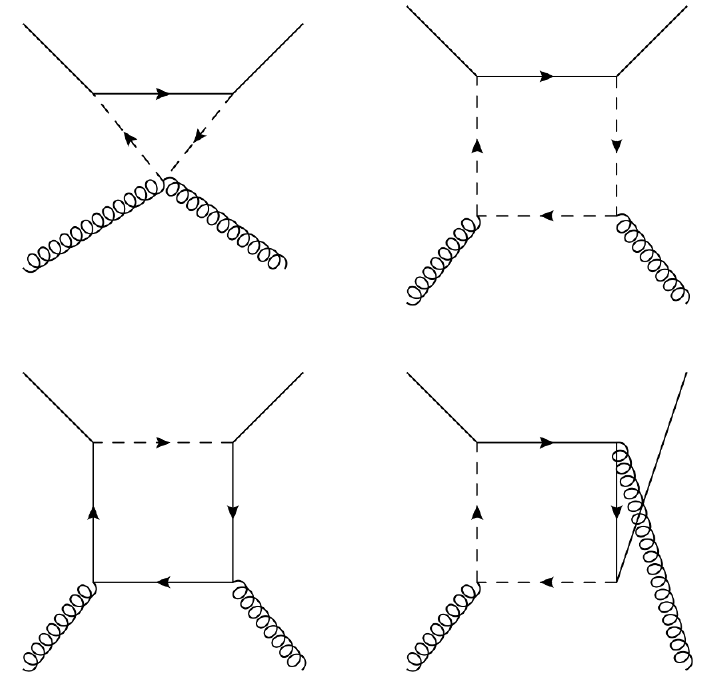
Figure 2 . Representative Feynman diagrams for DM scattering with gluons.